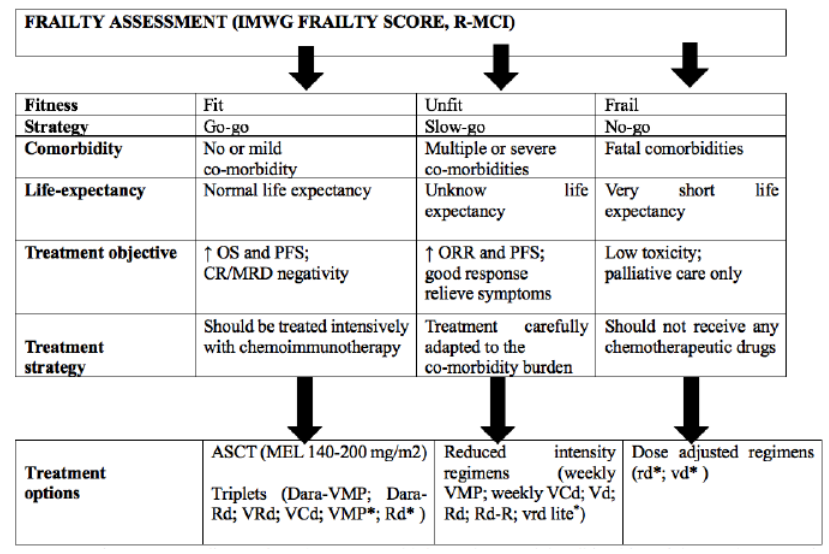
Figure 1. Management of transplant-ineligible MM patients according to frailty